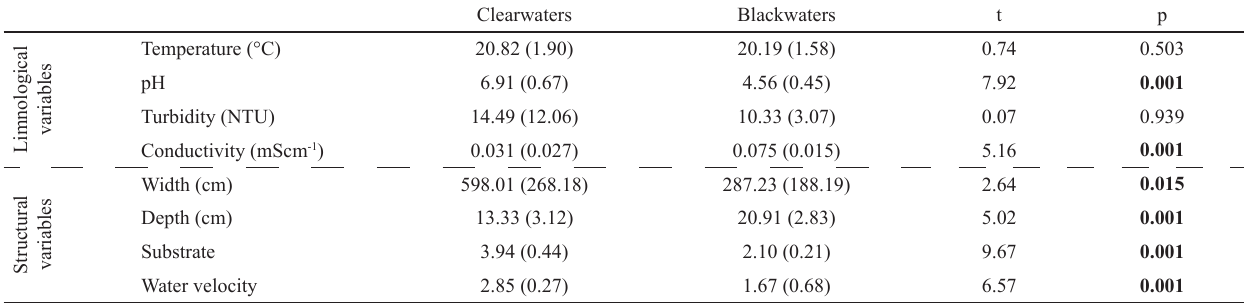
Table 1. Mean and standard deviation (in parenthesis) for limnological and structural variables in clear (n = 21) and blackwater (n = 6) streams, including the results of the t tests.